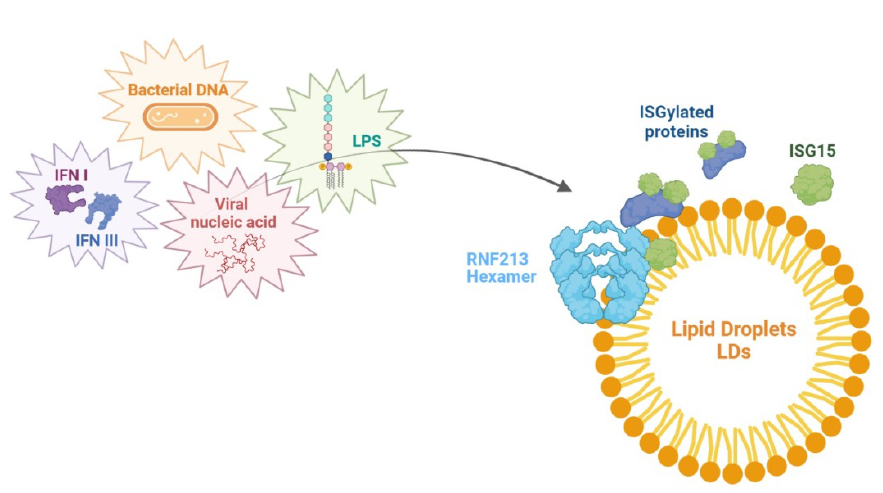
Figure 5. RNF213 oligomerization and translocation to lipid droplets (LDs) may serve for the creation of a binding platform for Interferon-Stimulated Gene 15 ( ISG15) and multiple ISGylated proteins (IFN I, interferon I; IFN II, interferon II).